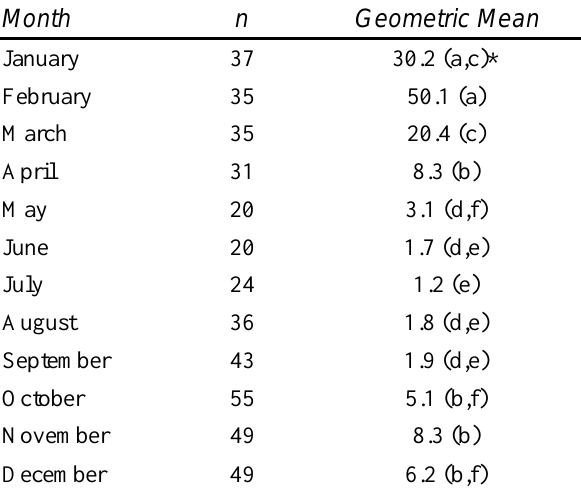
Table 1: Monthly variation in geometric means of fecal coliform counts in area 1. Data were pooled for